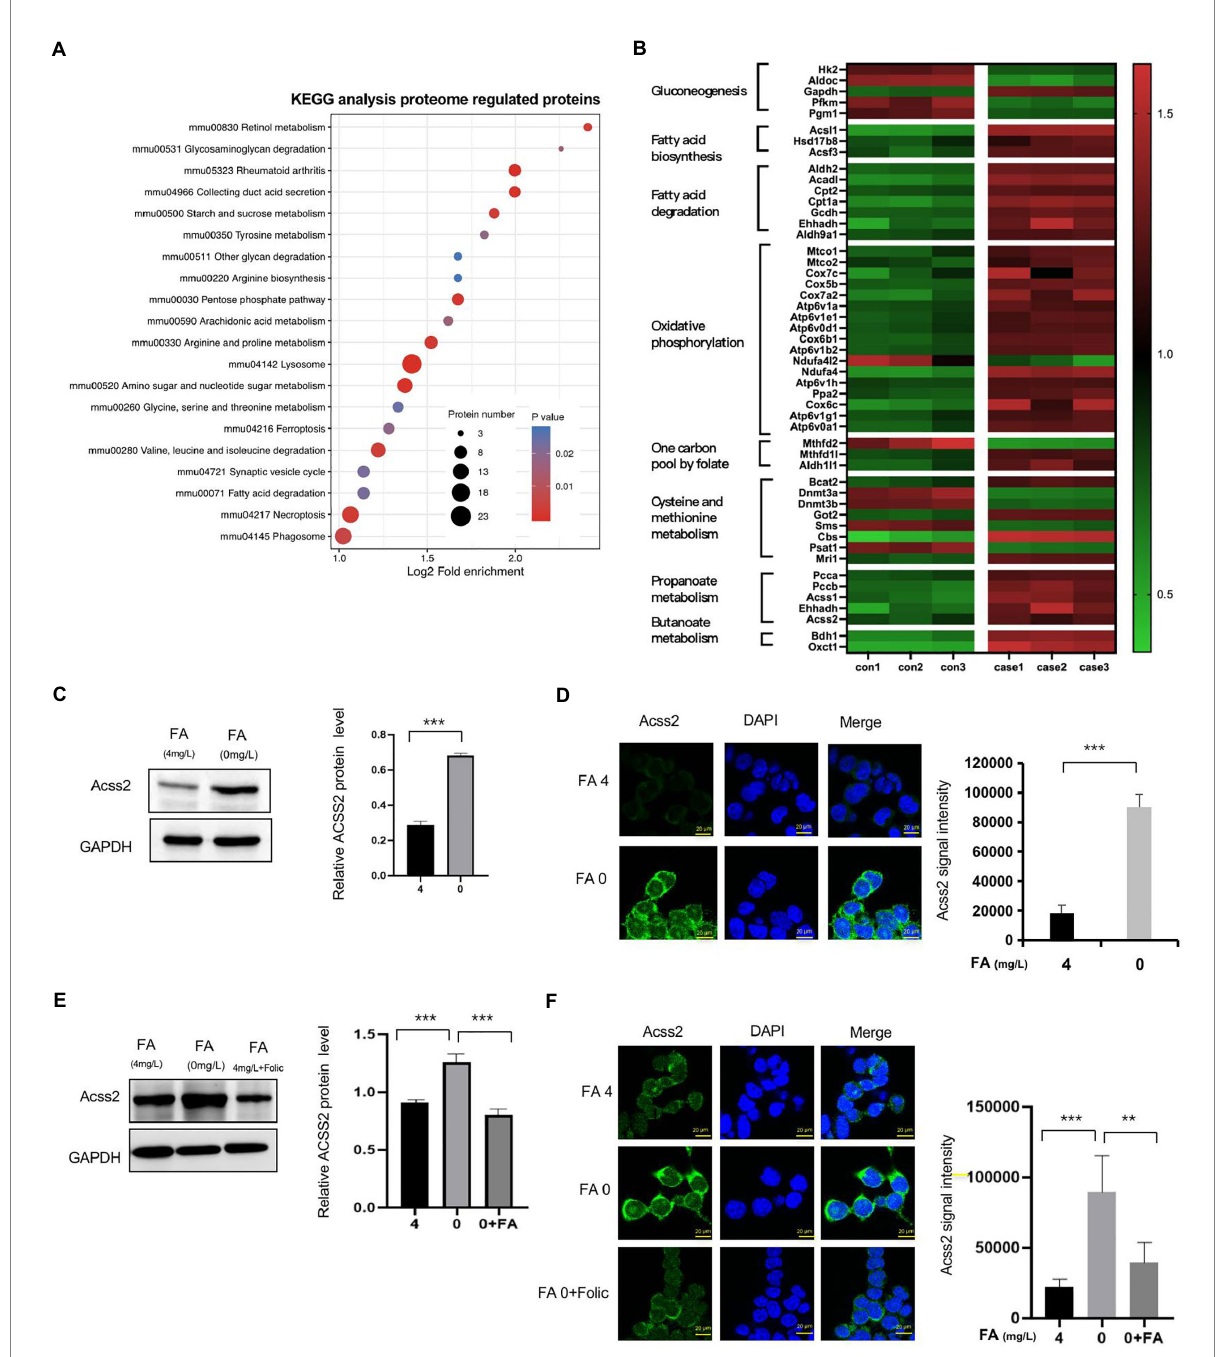
FIGURE 3 Classification of different proteins by KEGG and expression of ACSS2 under folate deficiency in mESCs. (A) Identified DEPs distribution in KEGG. (B) Heatmap of different expression proteins in high-confidence proteins shows metabolically distinct patterns in the eight cell states (ANOVA test, FDR q < 0.01). DEPs were grouped into clusters based on log 2 normalized intensity values using hierarchical clustering. (C) mESCs were harvested under normal folate versus folate deficiency (E) and supplementary folinic acid (50 mg/l) for 24 h analyzed by western blot indicated antibody. Relative ACSS2 protein level was generated by the quantification (ImageJ) of the ACSS2 signal normalized to the GAPDH signal. * p < 0.05, ** p < 0.01, *** p < 0.001. (D) Immunostaining using ACSS2 antibodies revealed discrete foci in mESCs under folate deficiency (F) and supplementary folinic acid (50 mg/l) for 24 h. Scale bar: 20 μ m. Data are shown as the mean (SD; n = 5). Nuclei were stained with DAPI (blue). * p < 0.05, ** p < 0.01, *** p <